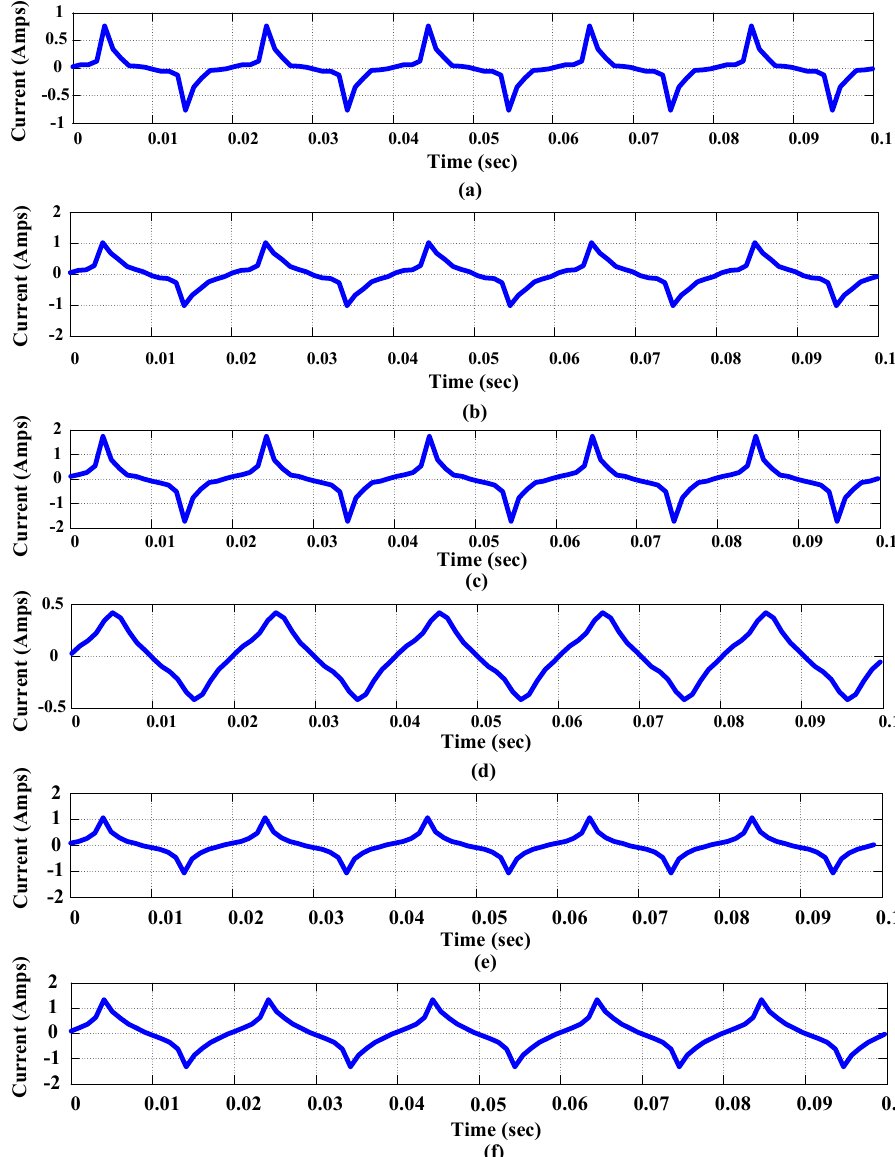
Figure 6. Any two loads. ( a ) CFL + LED load waveform; ( b ) CFL + exhaust fan load waveform; ( c ) CFL + SMPS of the PC load waveform; ( d ) LED + exhaust fan load waveform; ( e ) LED + SMPS of the PC load waveform; ( f ) exhaust fan + SMPS of the PC load waveform.